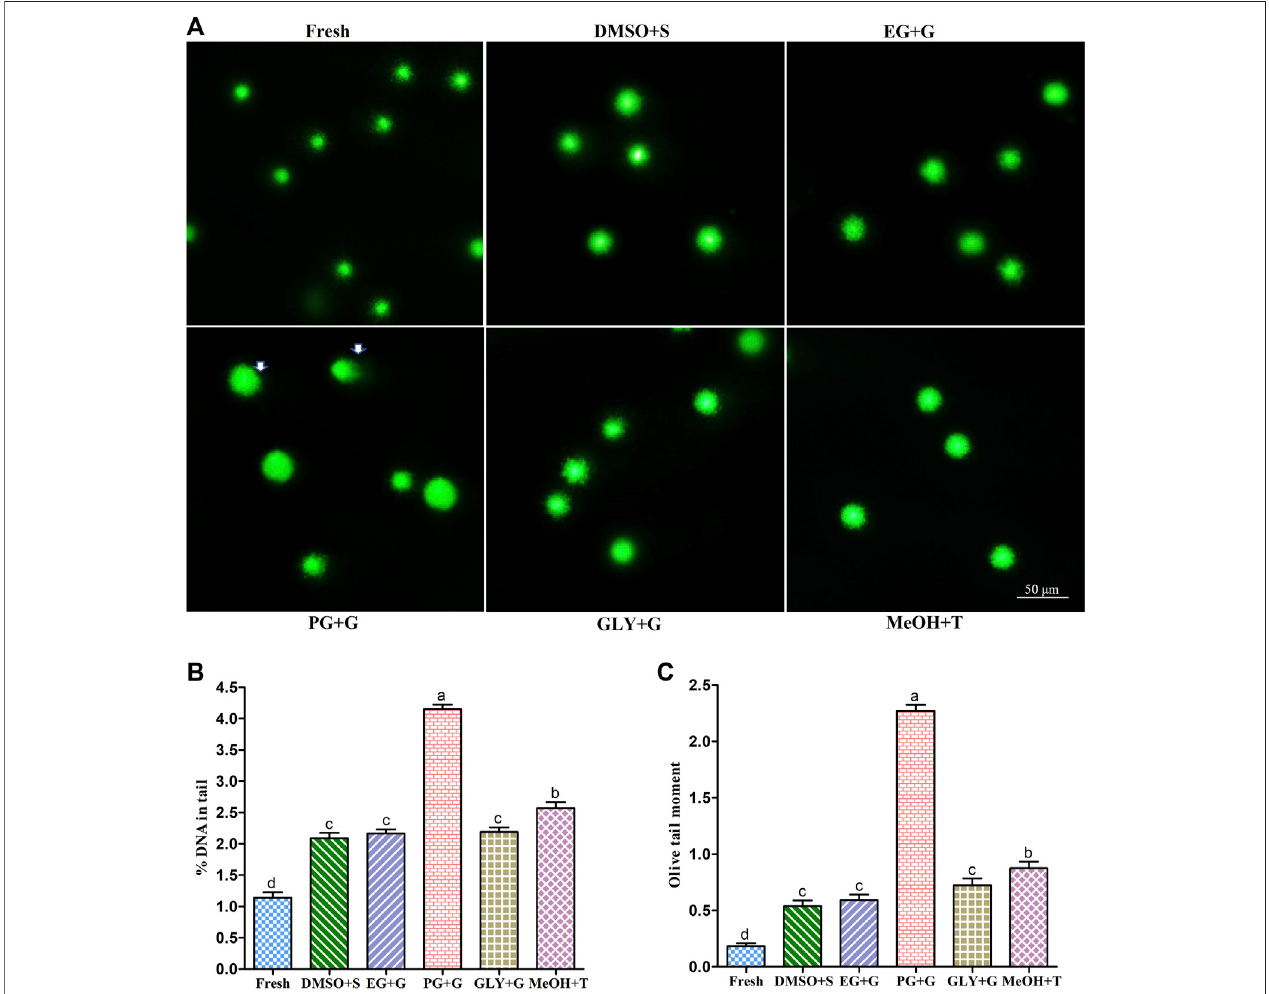
FIGURE5 | Deoxyribonucleic acid(DNA) integrityof sperm cryopreserved using saccharides (sucrose, glucose, and trehalose). (A) Vista green dye-stained comet images of fresh and cryopreserved sperm. (B) Sperm nuclear DNA fragmentation (% DNA in tail) in different types of post-thaw sperm. (C) Olive tail moment of different typesofpost-thawsperm.Resultsarepresented asmeanvalues±standarddeviation(n=5).DMSO+S:8%dimethylsulfoxide(DMSO)combinedwith3%sucrose(S), EG+G:8%ethyleneglycol(EG)combinedwith1%glucose(G),PG+G:6%propyleneglycol(PG)combinedwith2%glucose(G),GLY+G:2%glycerolcombined with 3% glucose (G), and MeOH + T: 2% methanol (MeOH) combined with 4% trehalose (T). Signi fi cantly different levels ( p < 0.05) are denoted by different letters.